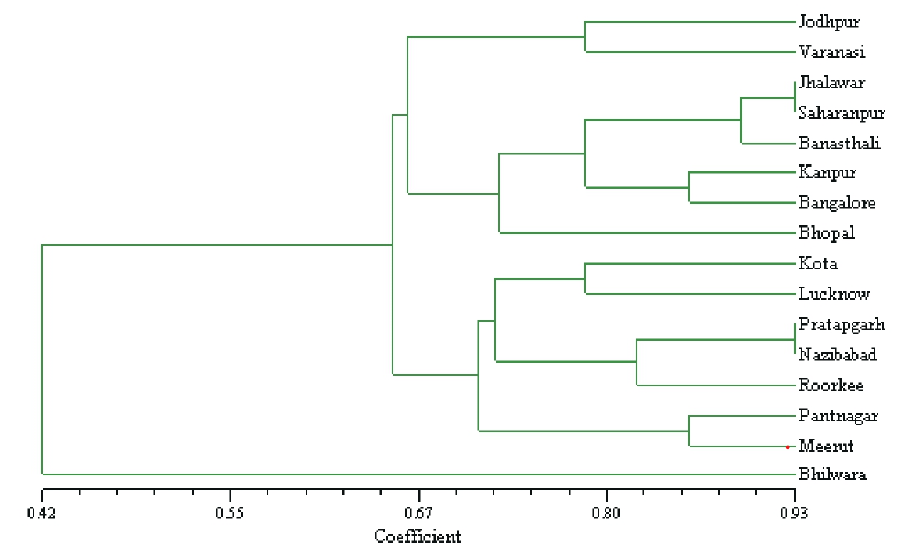
Figure 5. UPGMA dendrogram of the genetic relationships among 16 S. cumini genotypes based on HPLC. on